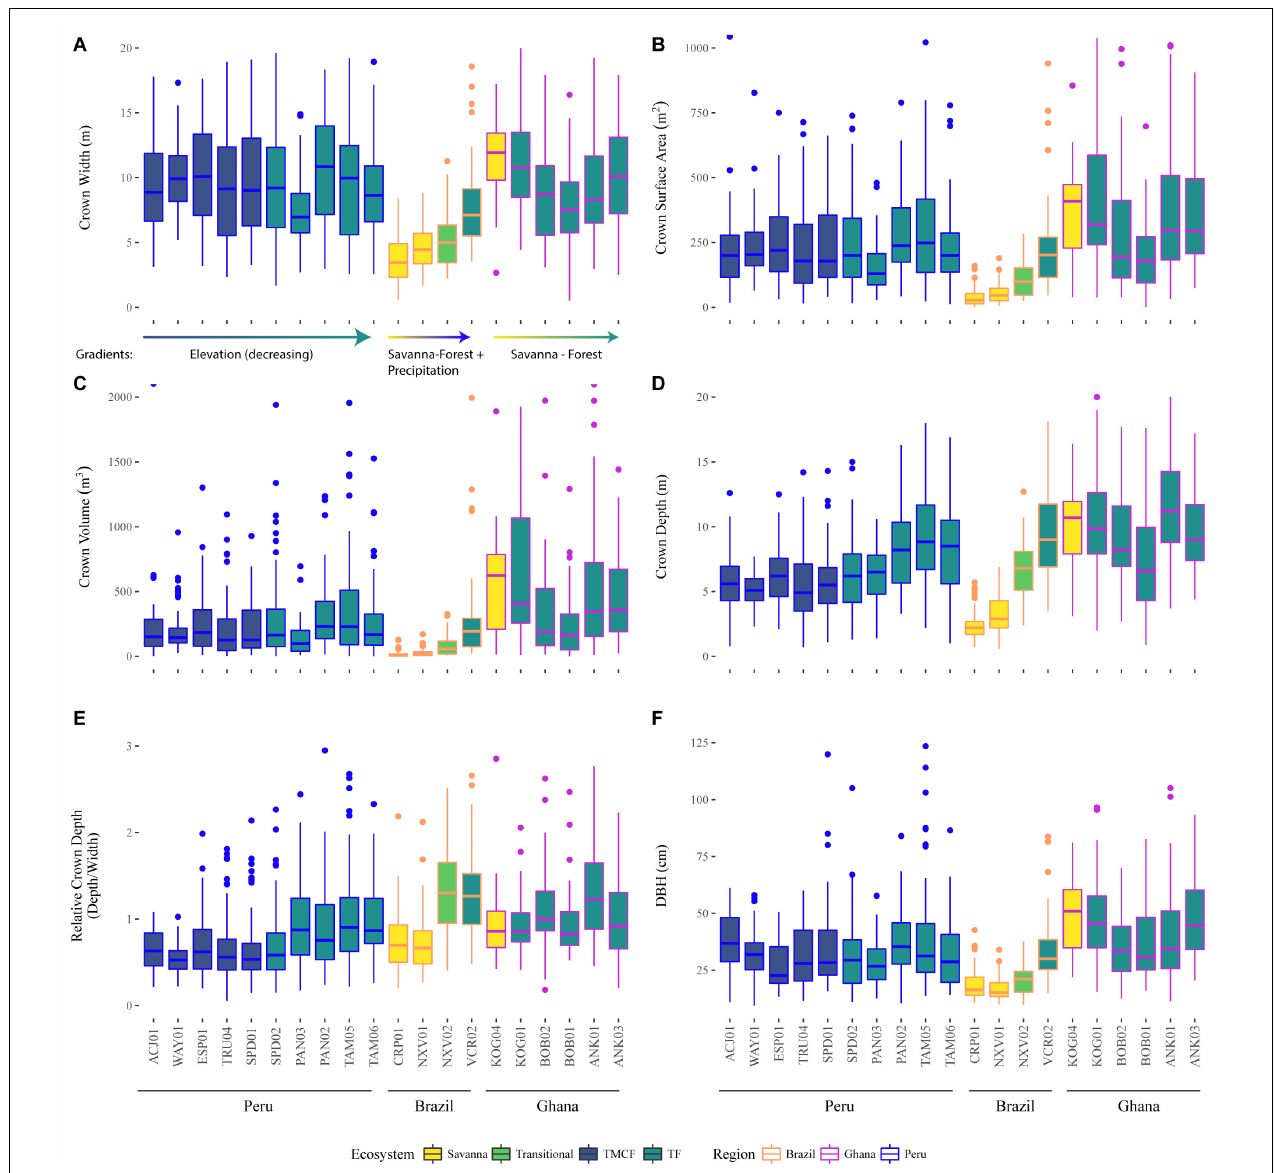
FIGURE 5 | Observed crown width (A) , surface area (B) , volume (C) , depth (D) , relative depth (E) , and stem diameter at breast height (F) , across sites ( x -axis), ecosystems (fill color), and regions (outline color and annotation). See tree height in Supplementary Figure S30 . Crowns with large relative depth values are elongated, and those with low relative depth are flatter. The data here are descriptive and have not been modeled or corrected for tree size or any other variable.